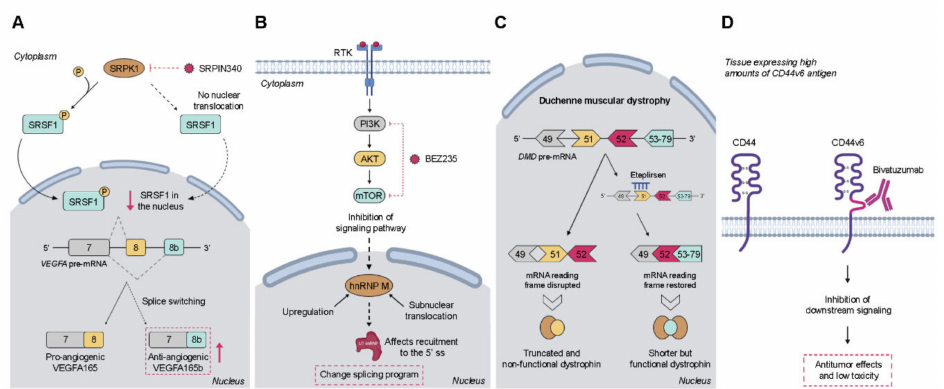
Figure 2. Examples of therapeutic strategies targeting alternative splicing (AS). ( A ) Targeting of protein kinases by small molecules to inhibit the post-translational phosphorylation of splicing factors. ( B ) Inhibition of signaling pathways by small molecules. ( C ) Splice-switching antisense oligonucleotides. ( D ) Targeting of cancer-specific isoforms by therapeutic monoclonal antibodies; (pre-mRNA—precursor messenger RNA; ss—splice site; RTK—receptor tyrosine kinase; hnRNP—heterogeneous